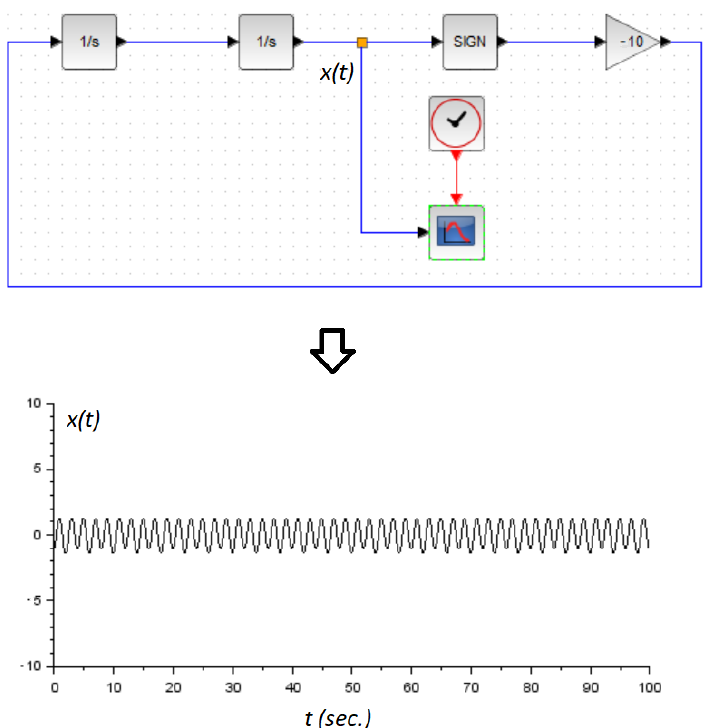
Figure 4. Numerical example of the oscillator dynamic (20). ( Top ): the Xcos block diagram of the system. ( Bottom ): the system response z ( t ) versus time. We use ˙ z ( 0 ) = 1 and z ( 0 ) = −